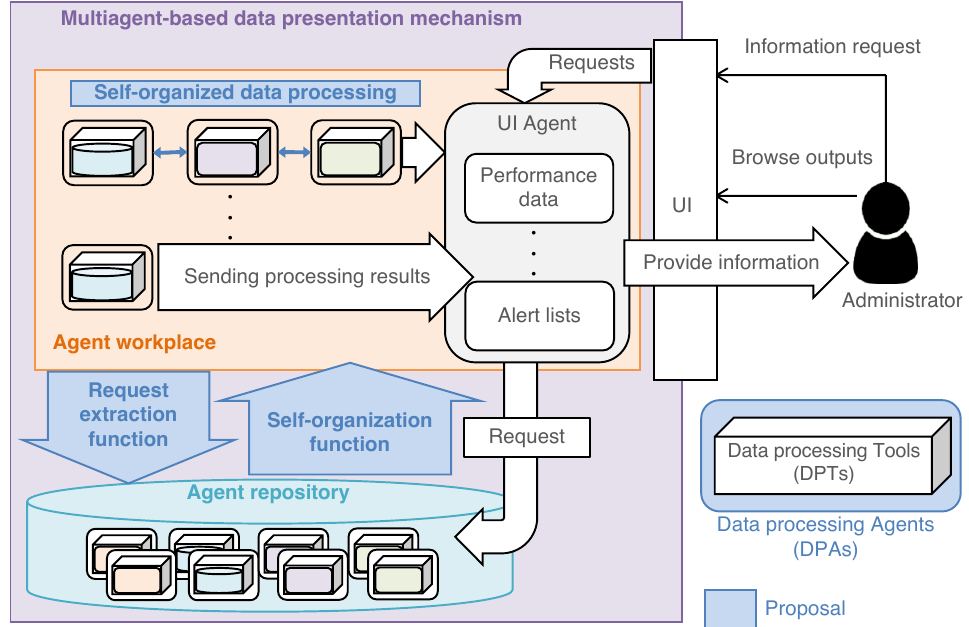
Figure 1. Schematic diagram of the multiagent-based data presentation mechanism (MADPM). The proposed MAPDM mainly consists of the encapsulation of data-processing tools (DPTs) and autonomous composition of multiagent